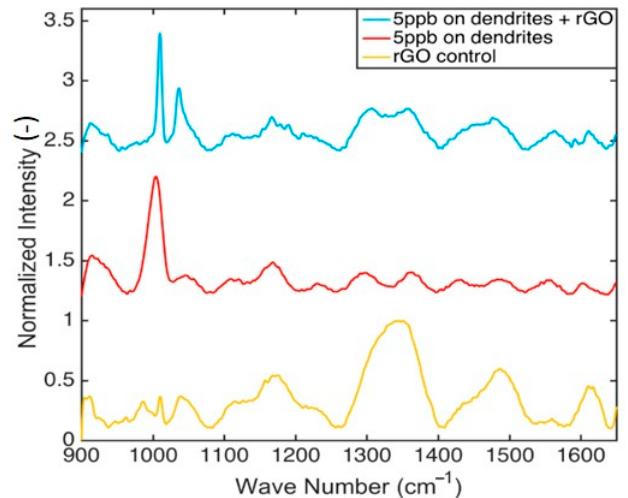
Figure 8. Normalized SERS spectra for methamphetamine (5 ppb) in artificial saliva: performance comparison between rGO-coated (blue line) vs. uncoated (red line) dendritic substrates. The spectrum of solvent on an rGO-coated substrate (yellow line) is included for reference.